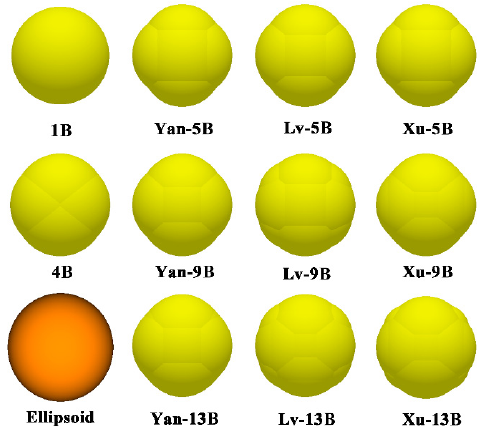
Figure 3. Comparison of models established by different approaches for one single soybean particle of S-42.